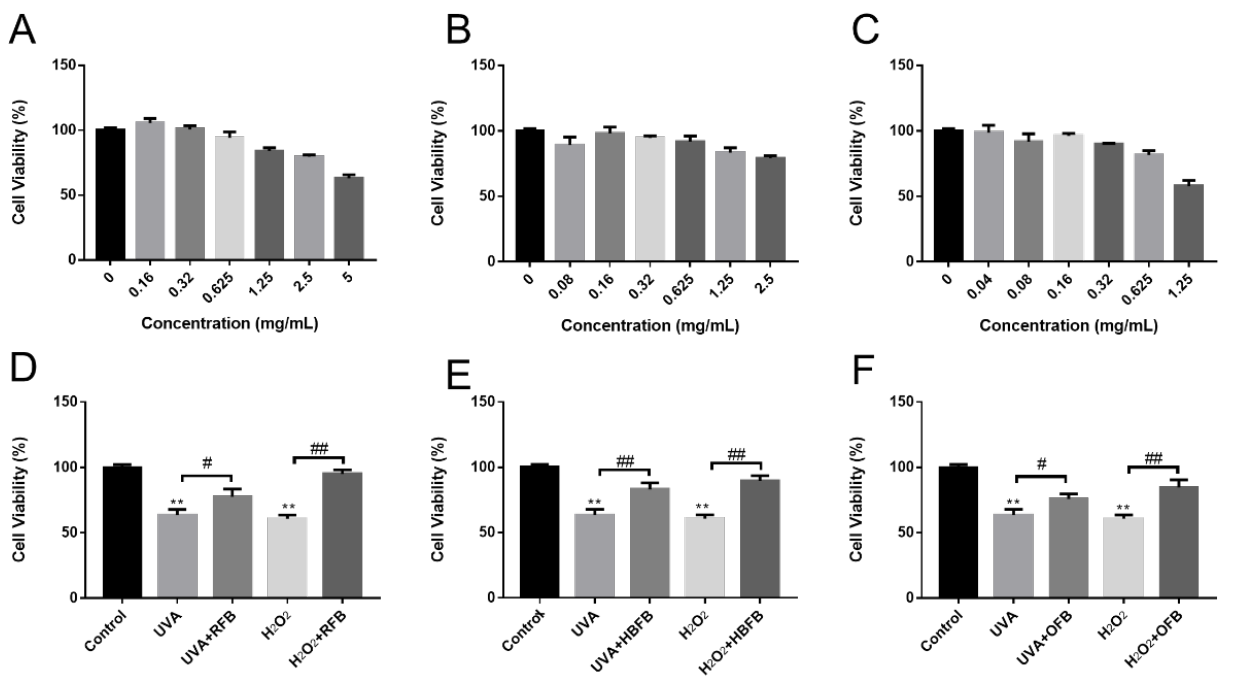
Figure 4. The toxicity of RFB ( A ), HBFB ( B ) and OFB ( C ) to HSF cells and the repair effects of RFB ( D ), HBFB ( E ), and OFB ( F ) on UVA-induced and H 2 O 2 -induced oxidative stress damage in HSF cells. The results were expressed as mean ± SD ( n = 6). The discussed concentrations of RFB, HBFB and OFB were 0.625 mg/mL, 0.625 mg/mL, and 0.32 mg/mL, respectively. **, p < 0.01, UVA/H 2 O 2 - induced model compared with the DMEM-treated control. # p < 0.05, and ## p < 0.01, RFB, HBFB, OFB compared with the Model.